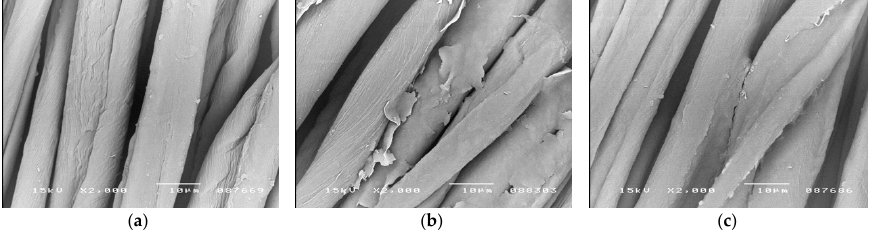
Figure 1. Scanning electron microscope (SEM) images of cotton fibers surface before and after fabric modification (magnification 2000×); ( a )—Control sample (before modification); ( b )—After impregnation with beeswax suspension and drying at room temperature; ( c )—Sample b after heat treatment at 120 °C for 1 min. Table 2. Putative identification of beeswax components analyzed directly with 109 AgNPET laser desorption / ionization mass spectrometry (LDI MS) based on LipidMaps